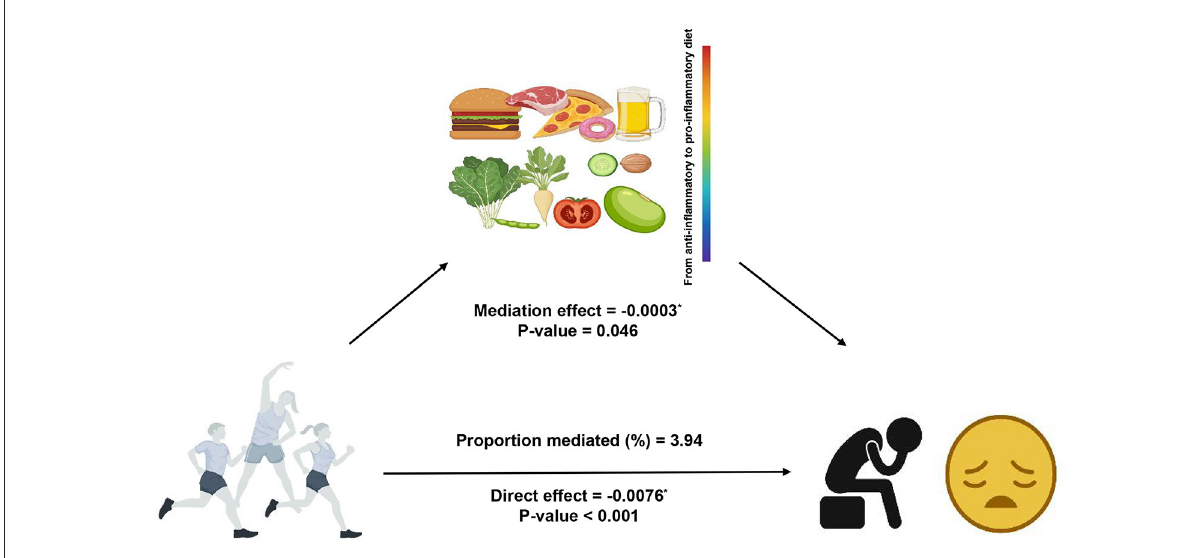
FIGURE2 Path diagram of the mediation analysis